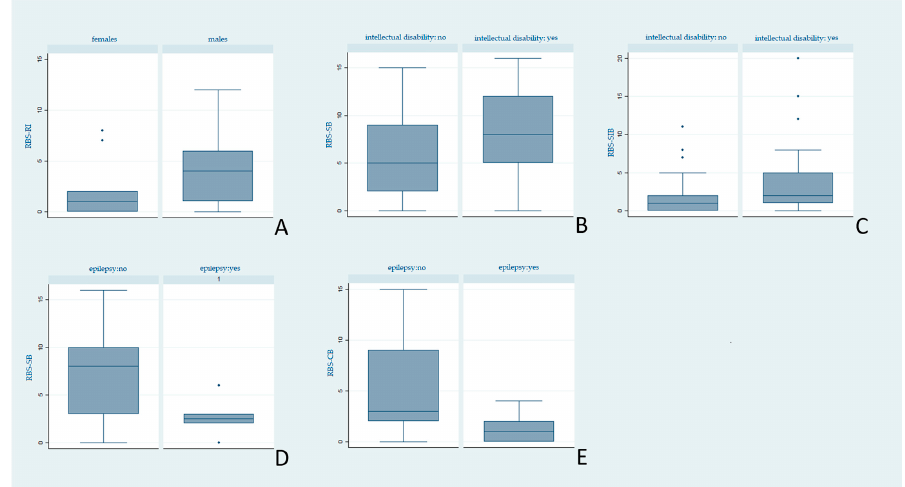
Figure 3. Differences in RBS-R median scores by clinical variables. Legend: Higher scores indicate more impairment. ( A ) Males showed more impairment in Restricted Interest (RBS-RI) than females ( p = 0.02). ( B , C ) Patients with intellectual disability displayed higher impairment in Stereotypic Behaviour (RBS-SB) and Self-Injurious Behaviour (RBS-SIB) than patients with normal QI ( p = 0.03, p = 0.02, respectively). ( D , E ) Subjects with epilepsy showed less impairment in Stereotypic Behaviour (RBS-SB) and Compulsive Behaviour (RBS-CB) than patients without epilepsy ( p = 0.02, p = 0.02, respectively).